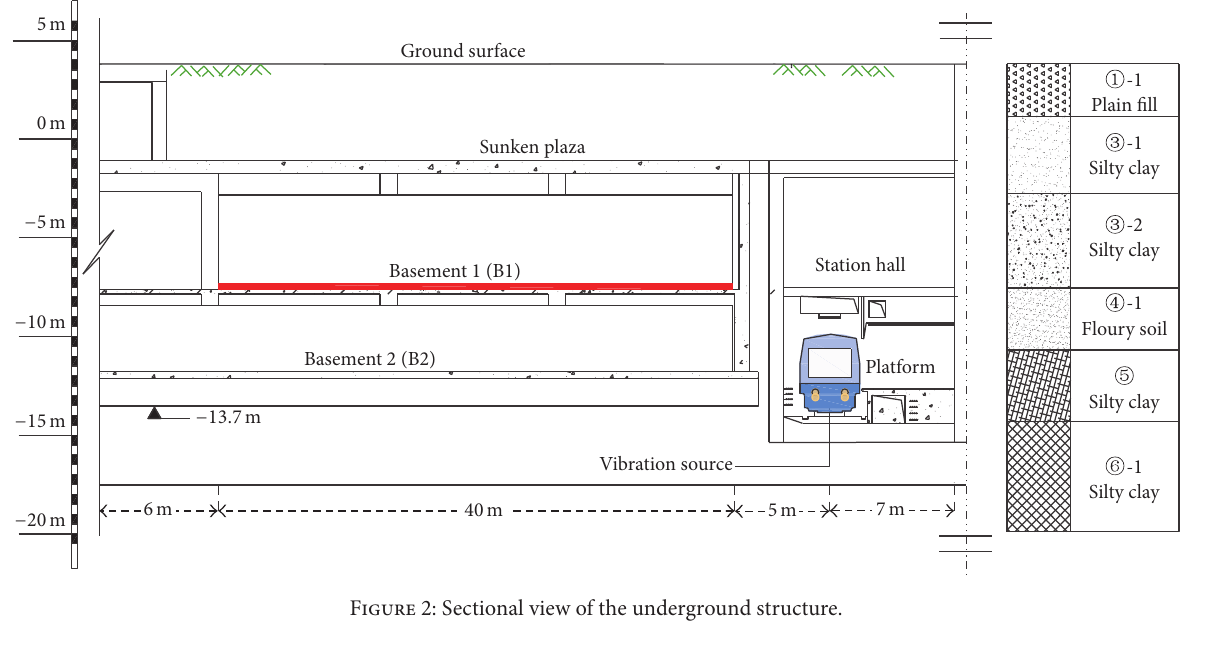
Figure 2: Sectional view of the underground structure.